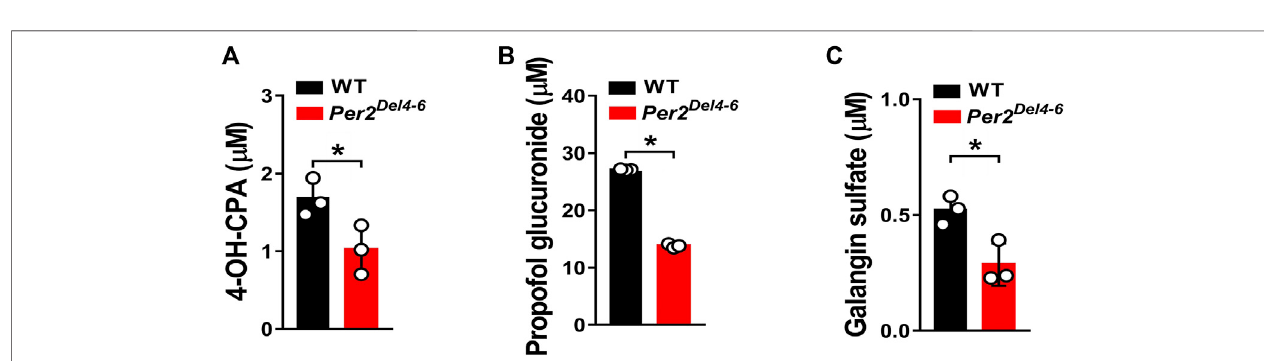
FIGURE3| MetabolicactivitiesofCYP2B10,UGT1A9andSULT1A1inPer2 Del4-6 micebasedoninvitrometabolismassays. (A) LiverCYPmicrosomalmetabolism assays showing attenuated metabolism of CPA in Per2 Del4-6 mice. (B) Reduced glucuronidation of propofol in liver microsomes of Per2 Del4-6 mice. (C) Sulfation assay showing reduced hepatic metabolism of galangin in Per2 Del4-6 mice. Data are mean ± SD ( n (cid:1) 3). * p < 0.05 (t test).